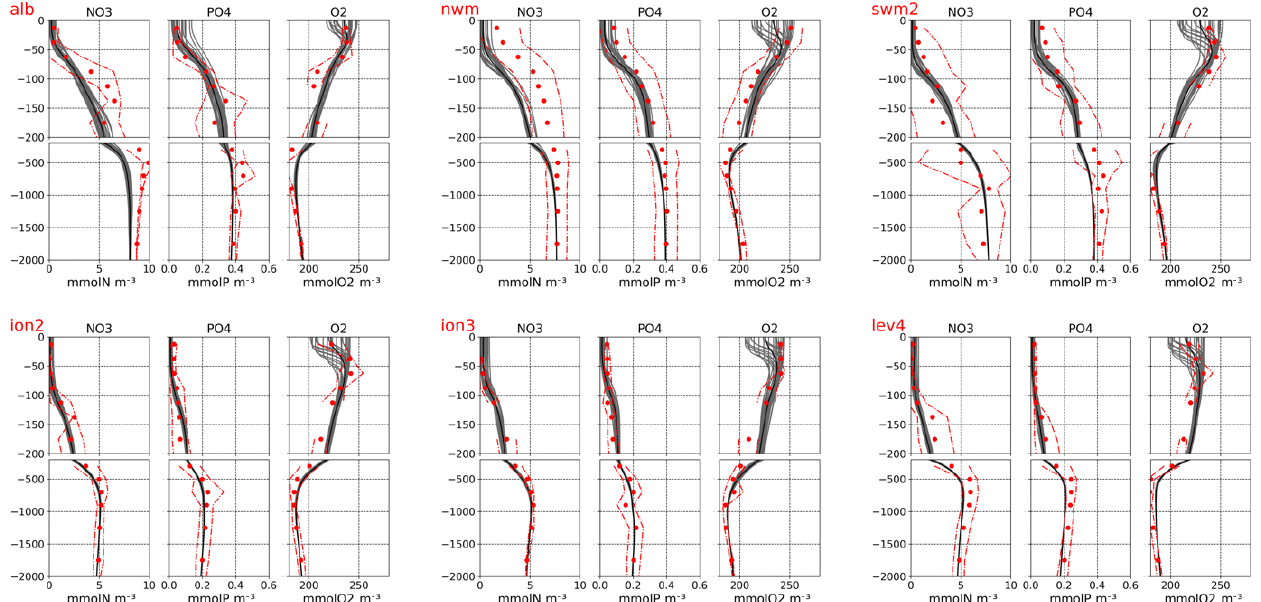
Figure 5. Monthly (grey lines) and mean (black lines) vertical profiles from the qualification run for selected sub-basins of Fig. 2 compared with climatological profiles (red dots) and variability ranges (one standard deviation, red lines) of nitrate, phosphate, and dissolved oxygen retrieved from the NODC-OGS